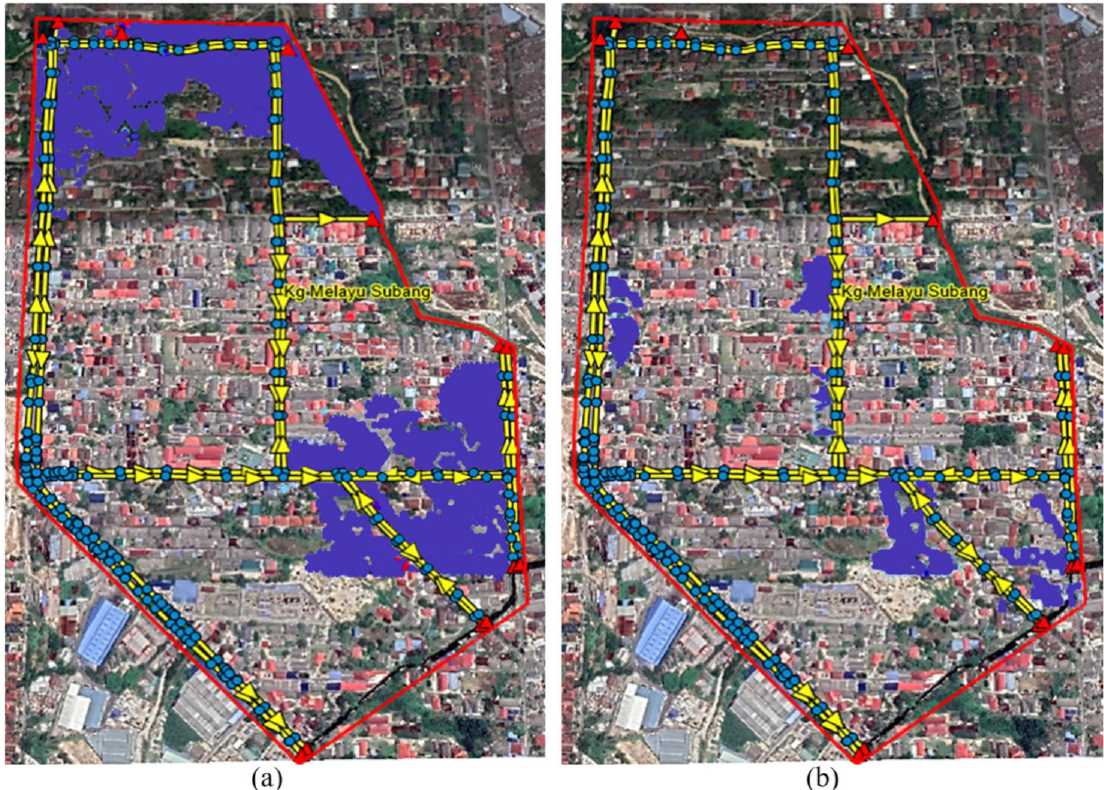
Figure 9. Comparison of flood extent between the scenarios with ( a ) historic drainage in 2015 (scenario 1) and ( b ) the current drainage in 2020 (scenario